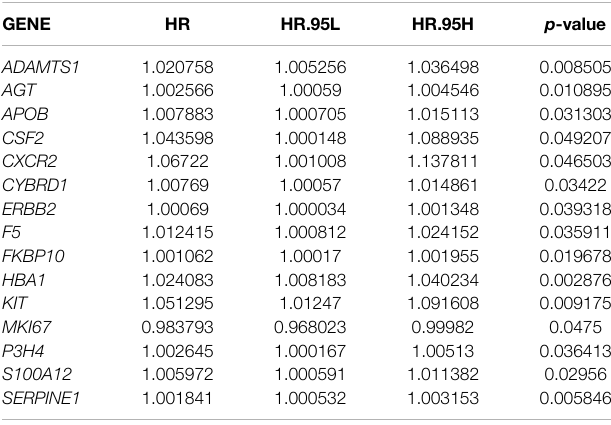
TABLE 1 | Univariate Cox proportional hazards regression analysis.